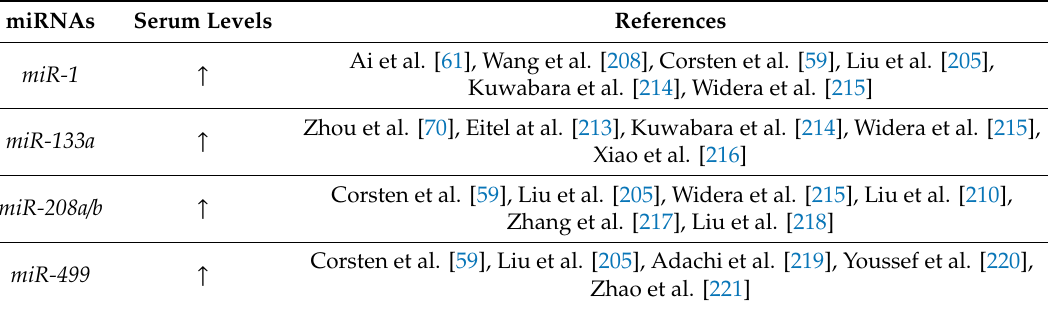
Table 2. miRNA regulation in acute coronary